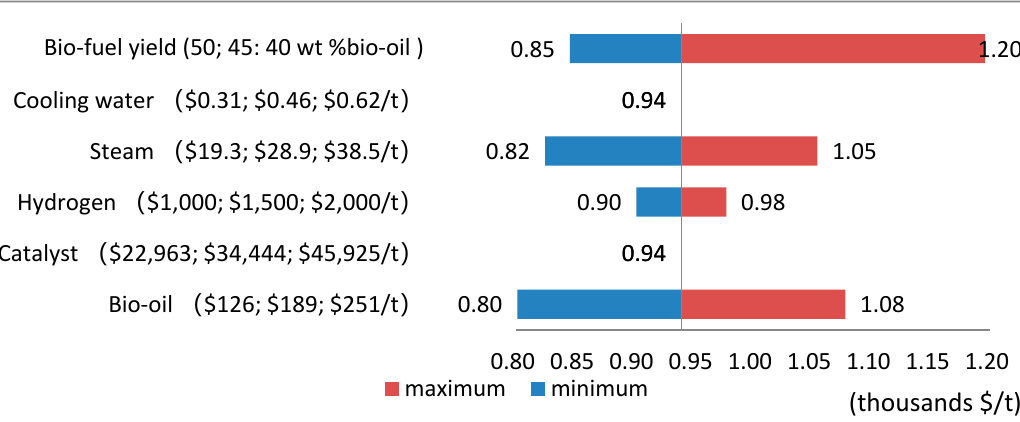
Figure 5. Sensitivity analysis for the practical production costs.